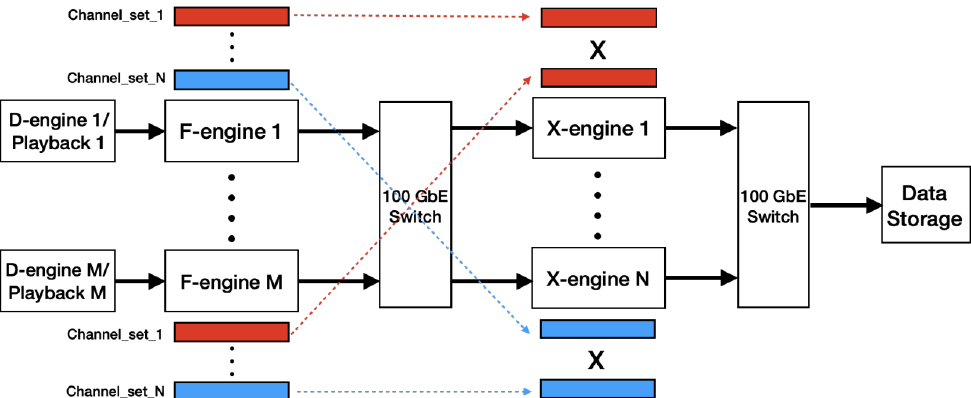
Figure 1. Level architecture of the proposed packetized FX-type correlator pioneered by CASPER. From left to right, note the D-engine samplers or VLBI playback recorders, the F-engines, a fast network switch implementing the corner-turner transpose, the X-engine, and archival visibility data storage. Not shown is the beamformer B-engine typically co-located with the